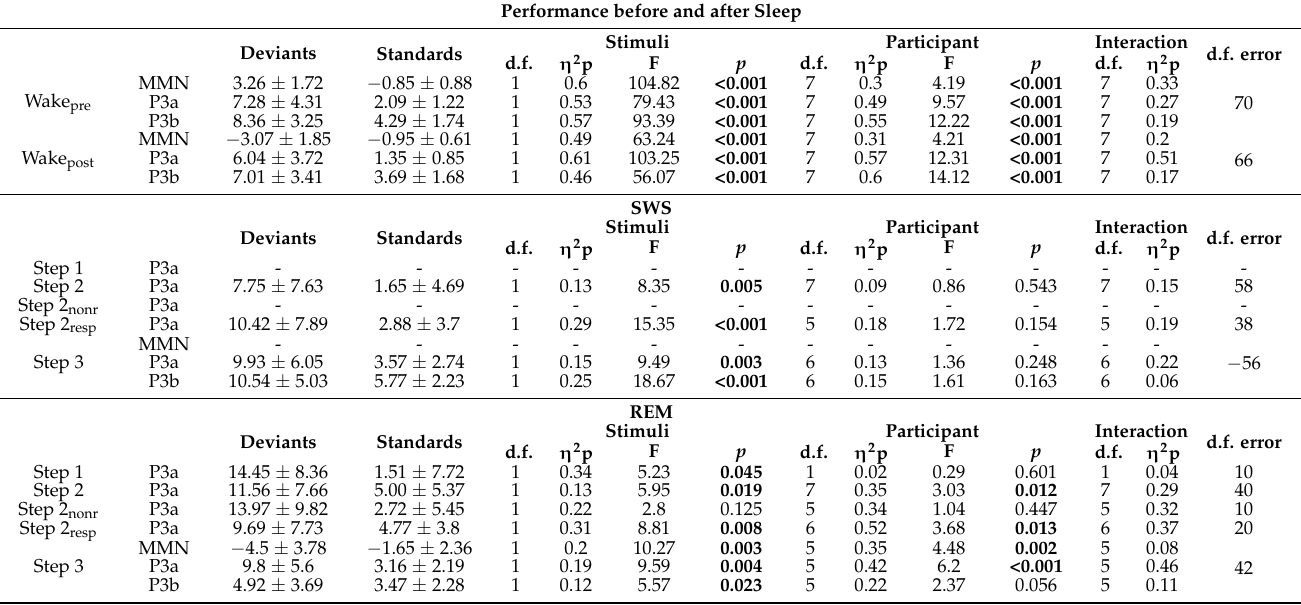
Table A5. Comparison of maximum amplitude difference between sounds for local